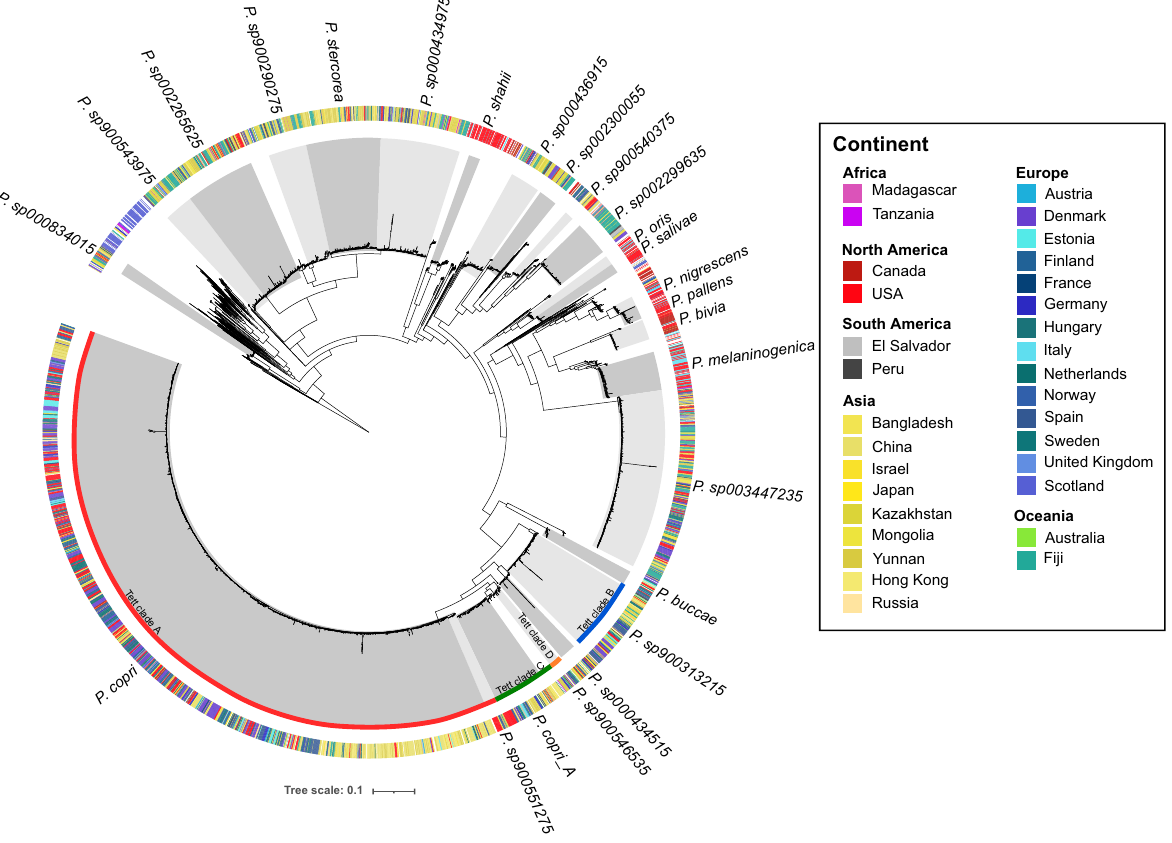
Figure 1. Phylogenetic tree representing phylogenetic relationships among Prevotella isolates and metagenome- assembled genomes (MAGs) recovered from human gut metagenomes. Five Paraprevotella genomes were used as outgroup to root the tree. MAGs included in this tree were downloaded from publicly available repositories 15,17,18 and from healthy human gut metagenome surveys of Hong Kong 24 and Yunnan populations 25 . Genomes were dereplicated at 99% average nucleotide identity (ANI) and a concatenated amino acid alignment consisting of 120 phylogenetically informative marker genes (from GTDB) was used to infer phylogenetic trees using IQTREE2. Taxonomy labels from GTDB are shown for species represented by at least 20 genomes (i.e., lower odds of spurious misassemblies or genome binning) (see Table S2 for genome counts); species boundaries are indicated by the alternating grey shades. Note that the GTDB-based taxonomy used here is not comparable to the four P. copri clades A–D from Tett et al. 1 - these four clades from Tett et al. 1 are indicated separately in the figure. The outer colour strip indicates source country/continent of the respective genomes shaded by